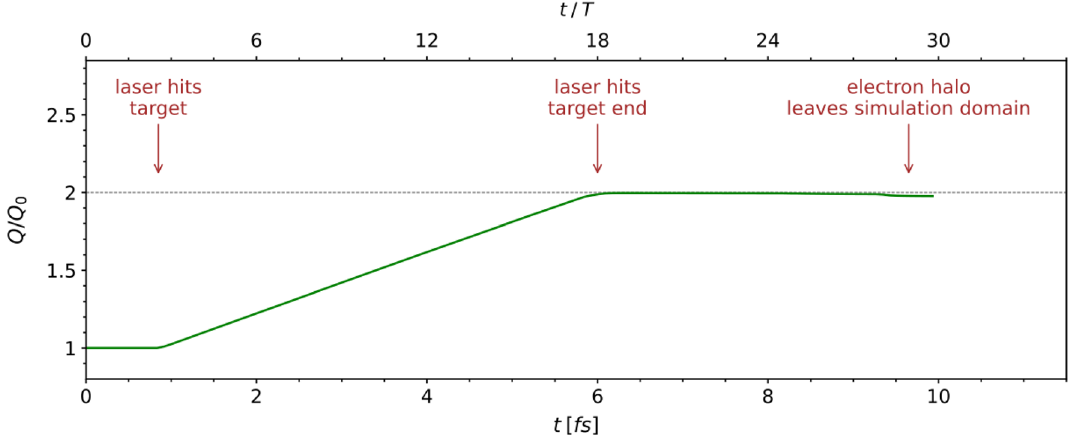
Figure 9. The maximum ratio between the total charge Q in the simulation domain at any given time and the total charge Q 0 at t = 0, proves that ionization is complete. There are 3 “free” electrons for each Carbon atom at t = 0 and twice as many for each Carbon atom when the laser pulse reaches the right edge of the